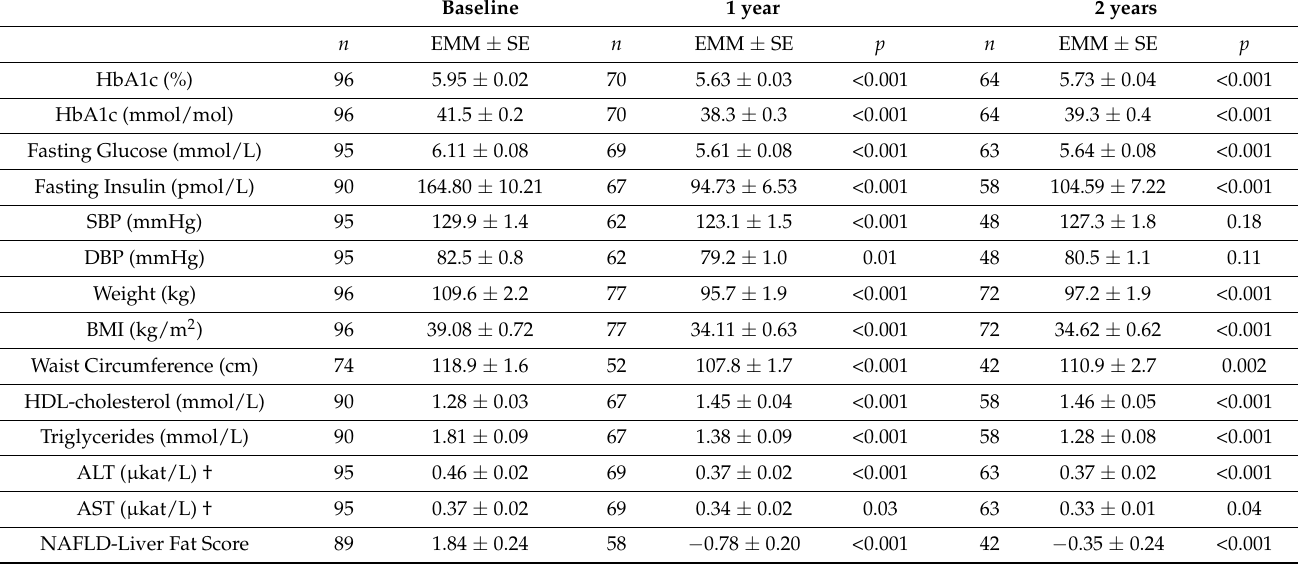
Table 2. Change in metabolic condition clinical markers compared to baseline.